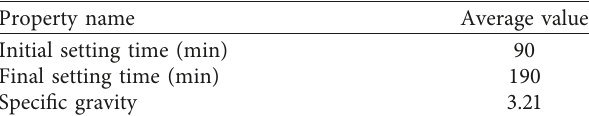
Table 1: Properties of